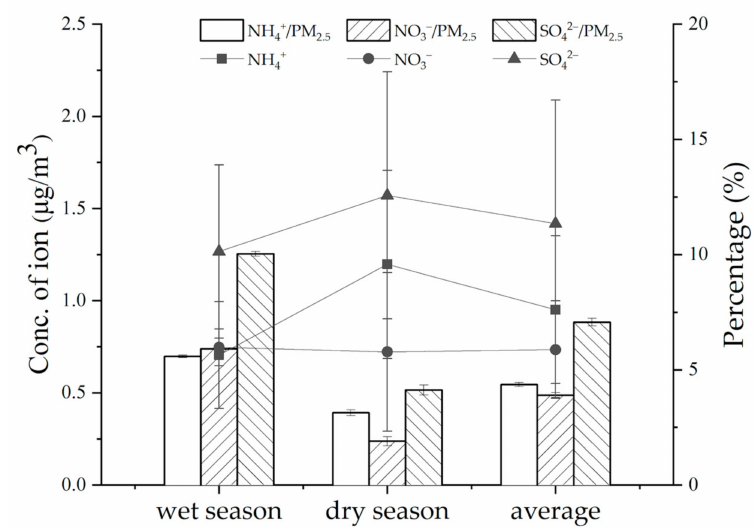
Figure 3. Seasonal variations of SIAs and their ratios in PM 2.5 in Baoshan.